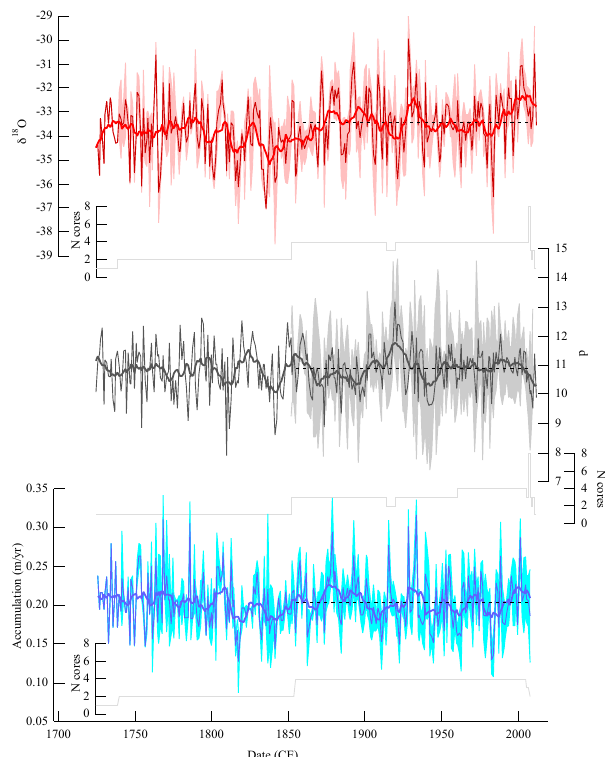
Figure 2. NEEM records from shallow ice cores and snow pits; from top to bottom: δ 18 O, deuterium excess (“d”) (both reported in ‰) and accumulation (in myr − 1 ). The thin coloured lines repre- sent annual averages, and the shading the standard deviation within individual ice core records. The thick lines display 11-year bino- mial smoothing. The horizontal dotted line shows the average val- ues from 1850 to 2011. The dashed black lines display the number of shallow ice core records through time (from 1 to 4) as well as the number of pit records (from 1 to 10) spanning 2003–2011. No ac- cumulation estimate is available from these pit data due to the lack of systematic density